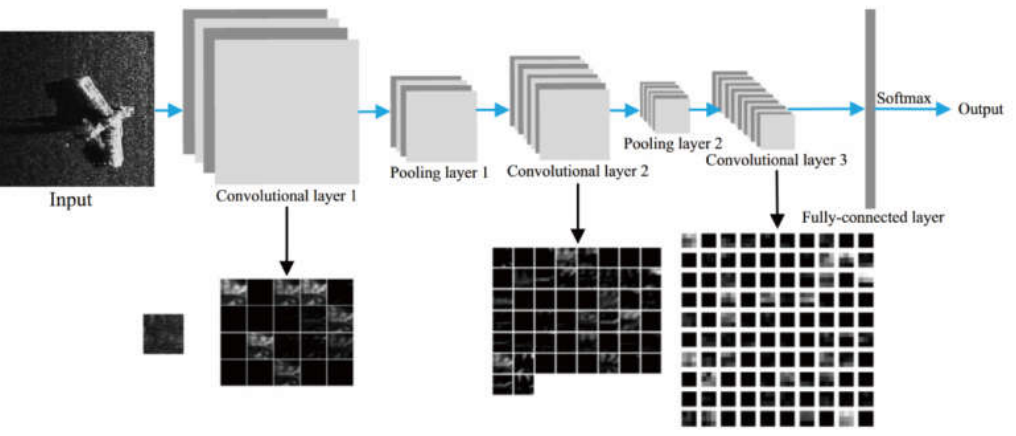
Figure 1. Structure of the classical CNN model [19].